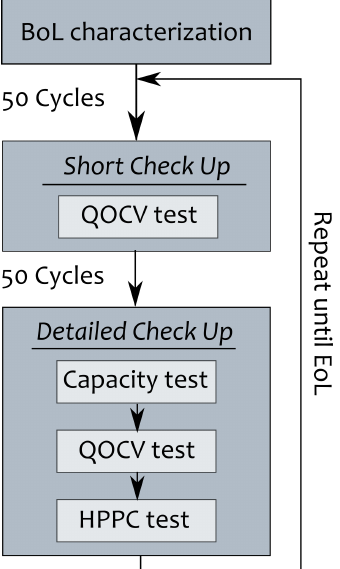
Figure 4. Flowchart representation of the testing procedure for lifetime testing of Si-alloy full